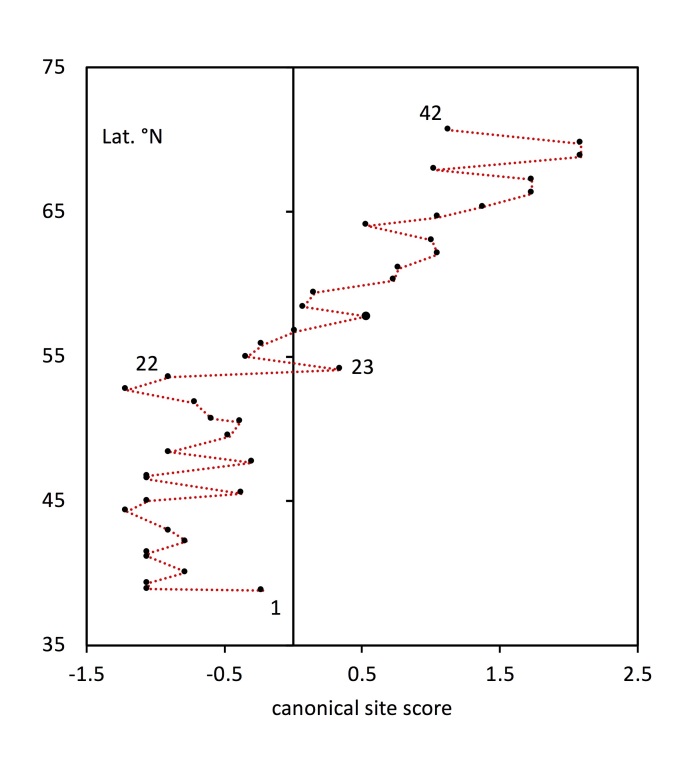
Comparison of site latitude with site scores on the latitude-constrained CCA axis. Correlation between the two would indicate that species composition at sites is strongly associated with latitude. The southern sites show no strong latitudinal pattern (sites 1-22: R² = 0.0165) whereas northern sites do (sites 23-42: R² = 0.756).